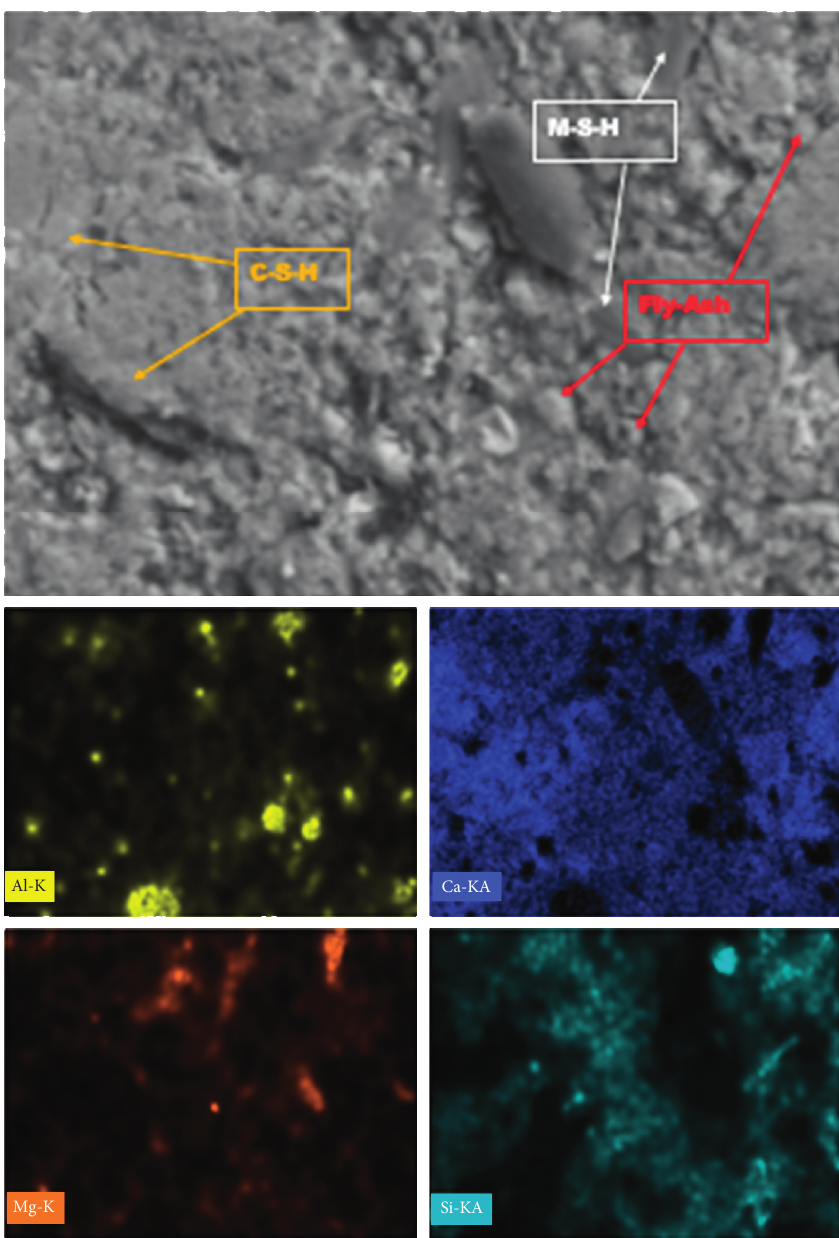
Figure 14: SEM image and corresponding EDX mapping for Al, Ca, Mg, and Si in